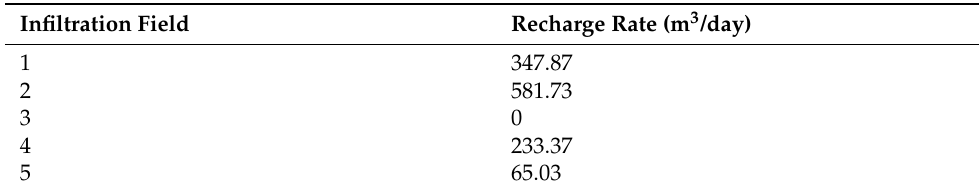
Table 2. Recharge rates from infiltration fields at the Ptujsko polje aquifer for the time used in the model. Infiltration Field